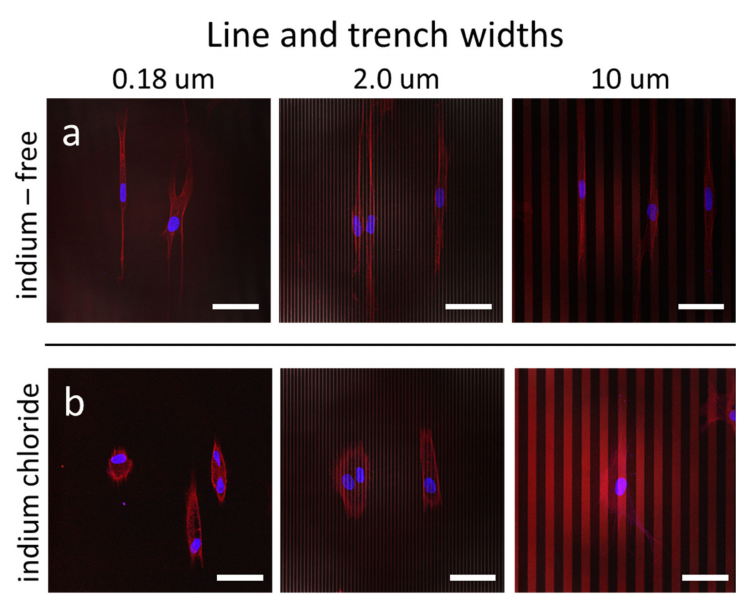
Figure 4. Fluorescence confocal micrographs of adherent cells on parallel line/trench structures incubated in ( a ) medium without InCl 3 and ( b ) medium containing 3.2 mM of InCl 3 . Images show cells elongated and aligned to the line axes when cultured in baseline media without indium chloride. After exposure to the indium chloride, cells are more compacted and less likely to align to the pattern axes. Scale bars correspond to 50 µ m. Cell nuclei appear blue (4 (cid:48) ,6-diamidino-2-phenylindole; DAPI), whereas F-actin microfilaments appear red (fluorescent phalloidin conjugate).